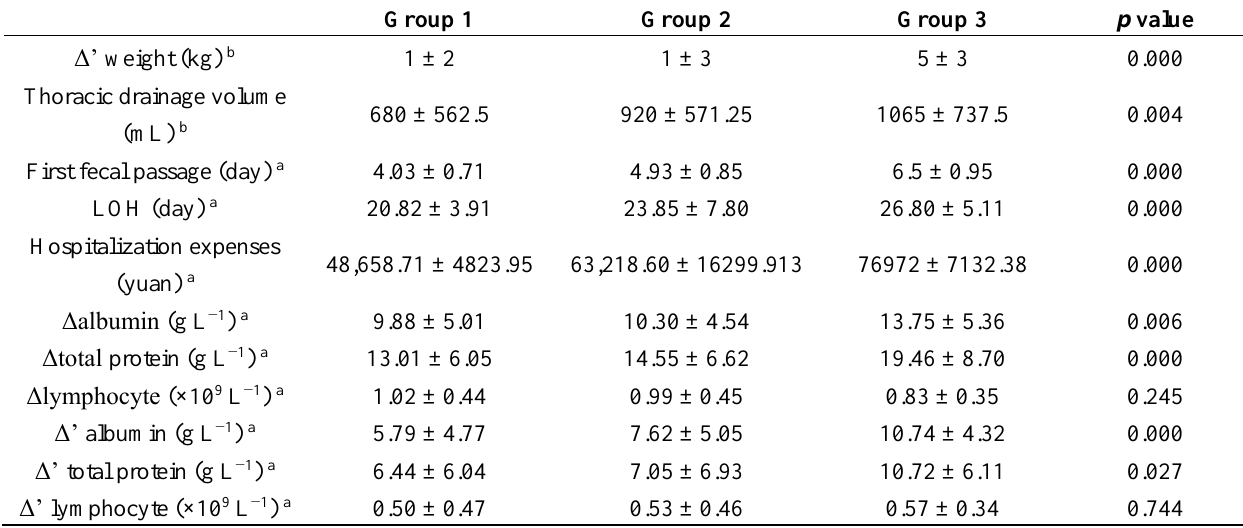
Table 4. Postoperative outcomes among 3